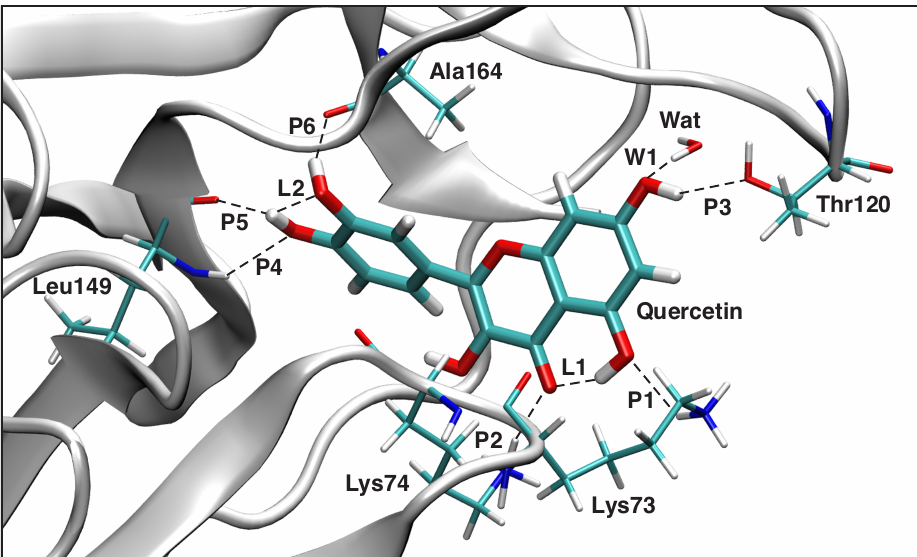
Figure 13. The optimized geometry of the Quercetin-NS3 complex. The QM part includes Quercetin, indicated by bold sticks; the MM part includes the NS3 protein, water molecules, and counter ions (for further details, see Supporting Information). There are nine hydrogen bonds (dashed lines) between Quercetin and the Ala164, Thr120, Lys73, Lys74, and Leu149 residues (thin sticks) of NS3, between Quercetin and a water molecule, and between two intramolecular hydrogen bonds; see also Figure 14. (Number of QM atoms: 32, total number of atoms: 3051). ω B97X-D/6-31G(d,p)/AMBER level of